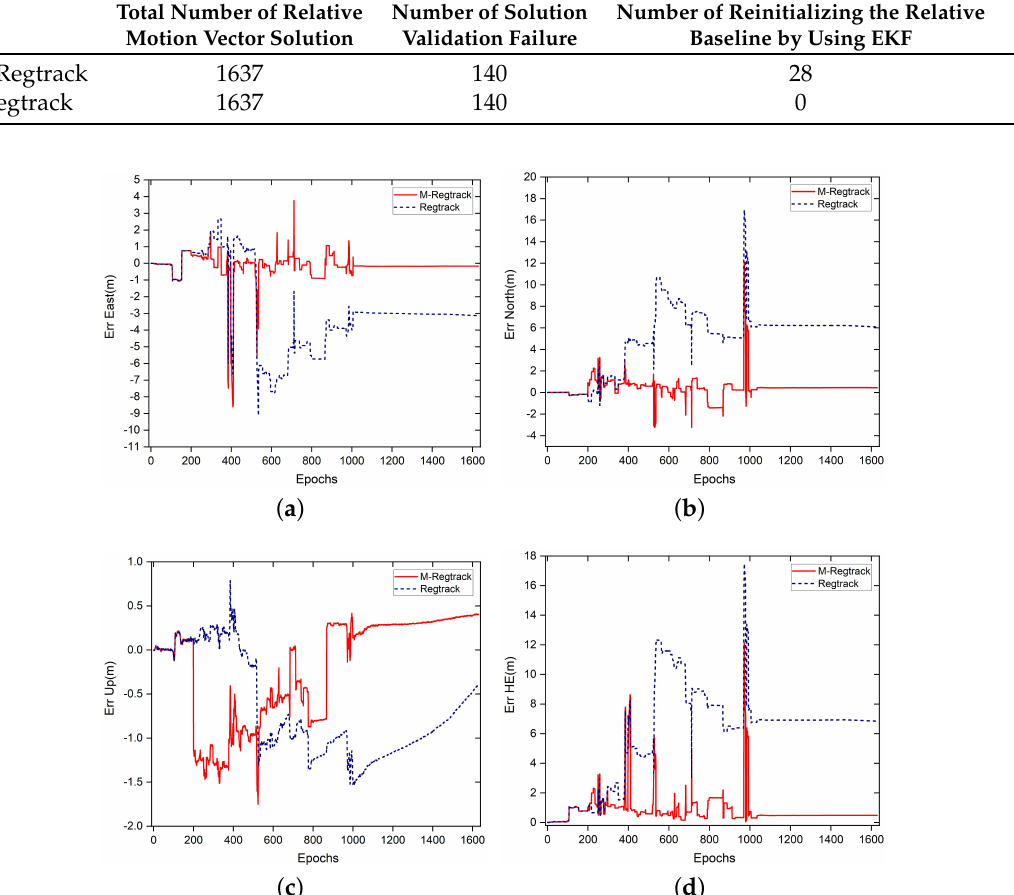
Figure 14. Error of absolute tracking result. ( a ) East component error. ( b ) North component error. ( c ) Up component Error. ( d ) Horizontal error results, where HE =